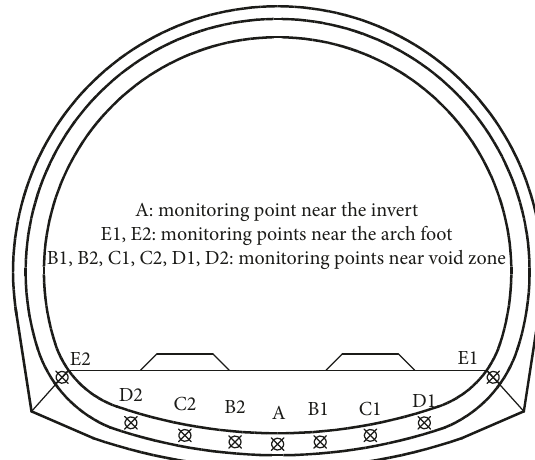
Figure 6: Schematic diagram for arrangement of monitoring points of